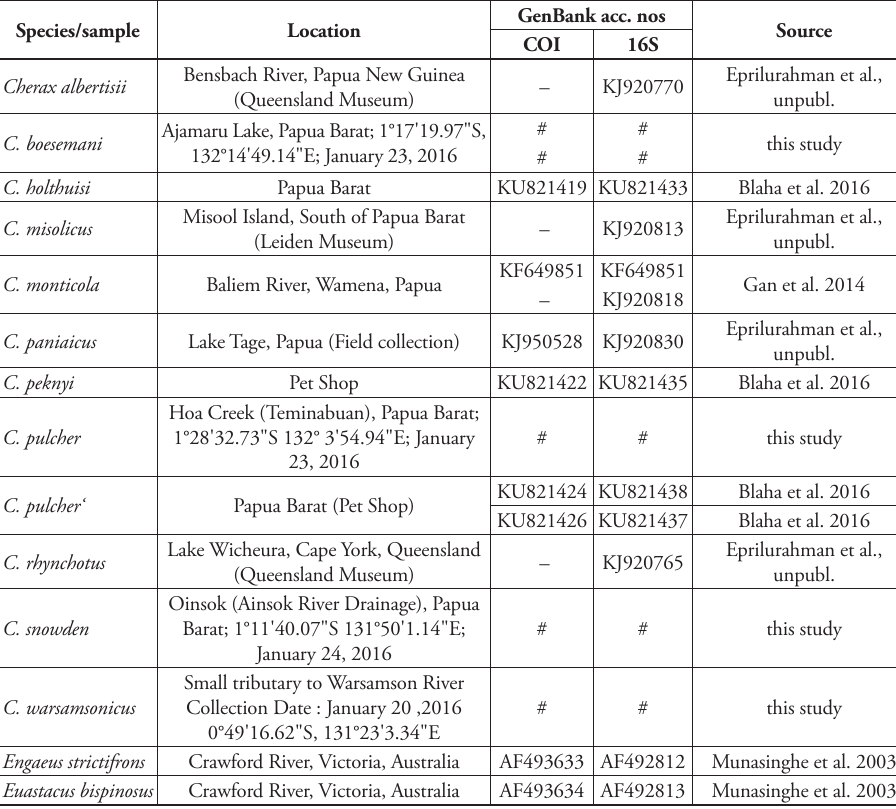
Table 1. Material studied with GenBank accession numbers.